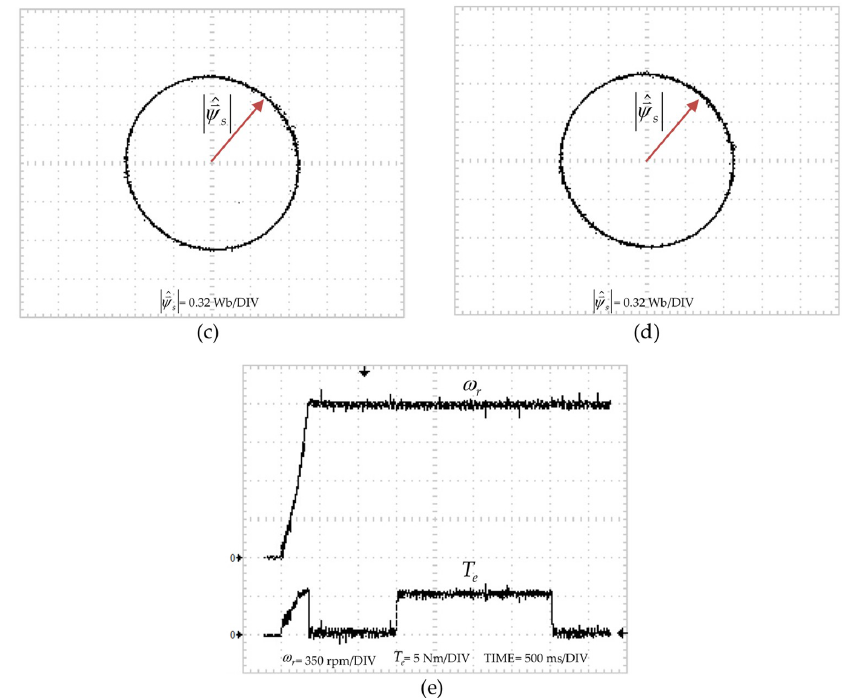
Figure 7. Experimental results when step speed from standstill to 1400 rpm then 100% step-load change ( a ) actual speed response ( ω r ), estimated speed response ( ˆ ω r ) and estimation error ( ω r − ˆ ω r ) when motor starting, ( b ) actual speed response ( ω r ), estimated speed response ( ˆ ω r ) and estimation error ( ω r − ˆ ω r ) during taking load, ( c ) stator flux trajectory when no load, ( d ) stator flux trajectory when full load, ( e ) actual speed response ( ω r ) and torque response ( T e ).